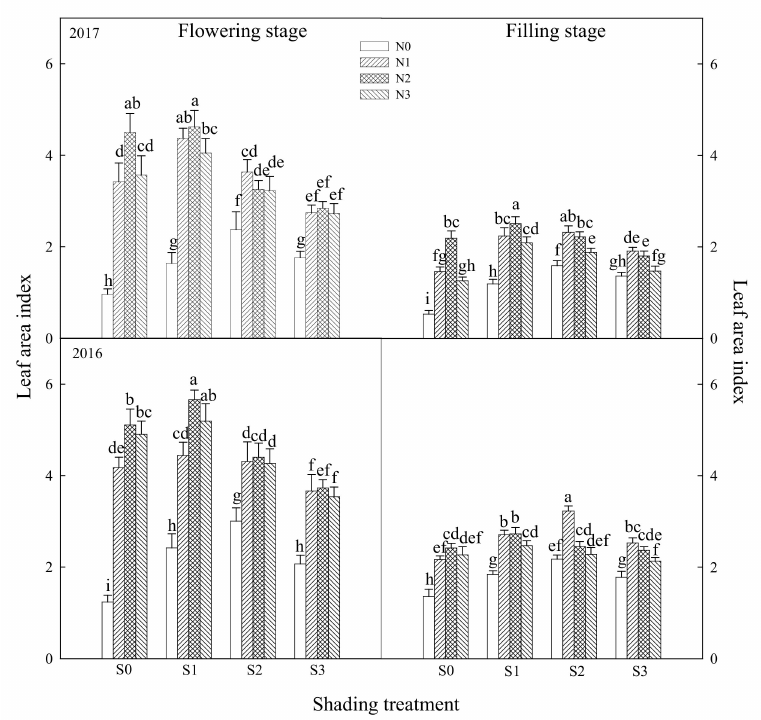
Figure 1. Effect of light and nitrogen treatment on the leaf area index (LAI) of wheat. Bars indicate SD (n = 3). Values within columns followed by the same letter are statistically insignificant at the 0.05